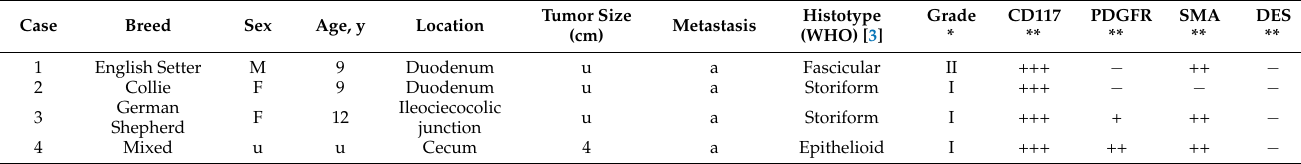
Table 2. Anamnestic information and histological results of the 17 canine GISTs. Abbreviations: F: female; FS: spayed female; M: male; MN: neutered male; u: unknown; y: years; a: absent (at the